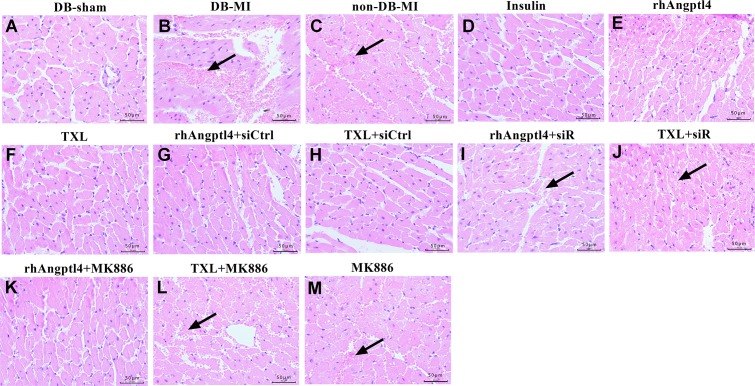
Comparation of parameters of myocardial injury, blood glucose and endothelial barrier integrity in reperfused rats.Area of necrosis, levels of CK activity and cTnI, blood glucose levels, microvascular permeability levels, myocardial focal bleeding score and endothelial cell apoptosis rate was compared among different groups. (A-C) Quantification of myocardial injury and necrosis; (D) Blood glucose levels; (E-G) Parameters of endothelial barrier integrity. Compared with the DB-sham group, *P<0.05, **P<0.01; Compared with the DB-MI group, †P<0.05, ††P<0.01; Compared with the TXL group, ‡P<0.05, ‡‡P<0.01; Compared with the rhAngptl4+siR group, §§P<0.01; Compared with the Insulin group, ¶¶P<0.01. N = 8 for each group. Abbreviations as in Fig 1.